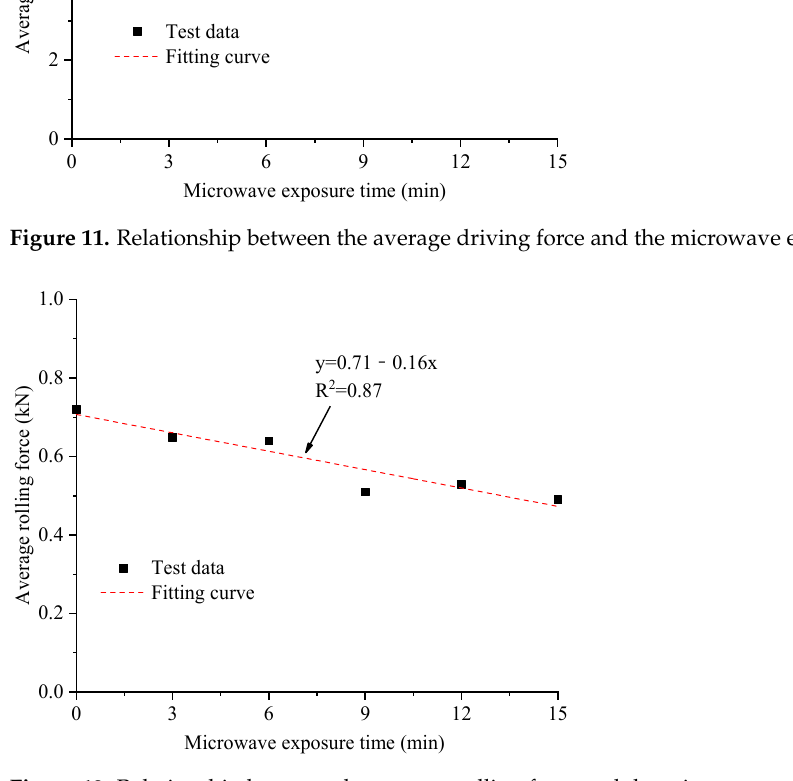
Figure 11. Relationship between the average driving force and the microwave exposure time. Table 4. The average rolling force at di ff erent microwave exposure times.